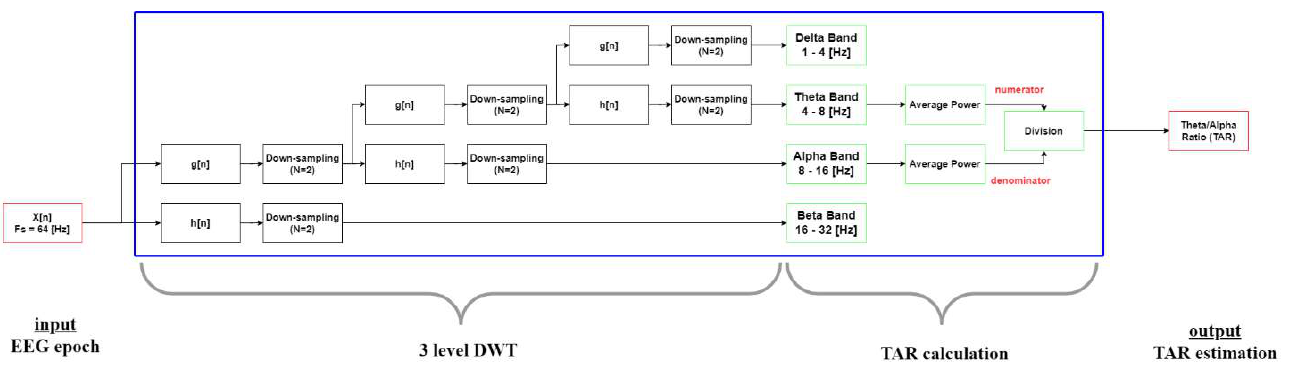
Figure 4. EEG preprocess pipeline.